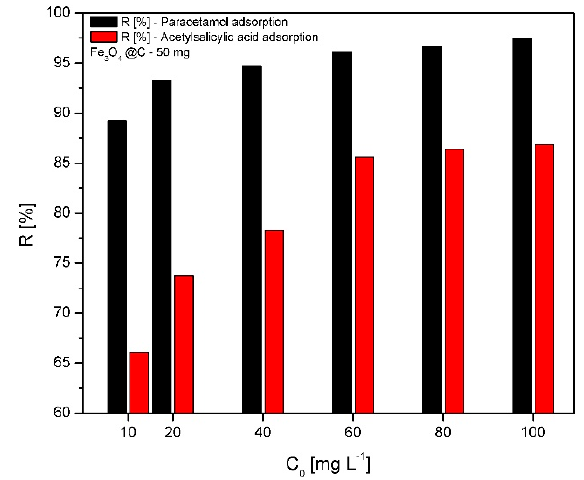
Figure 7. Removal efficiency of paracetamol and acetylsalicylic acid on the Fe 3 O 4 @C matrix. Figure 7. Removal e ffi ciency of paracetamol and acetylsalicylic acid on the Fe